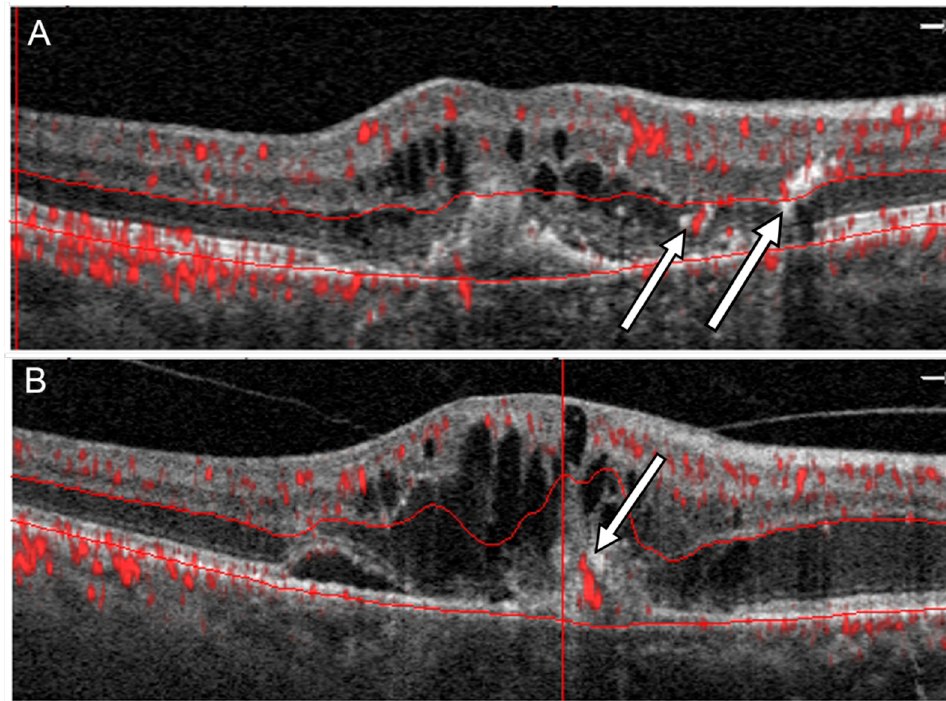
Figure 1. Two different patterns of flow in RAP in OCTA: ( A ) A flow signal in outer retina in vicinity of hyperreflective lesions corresponding to IRN (arrows), ( B ) a flow signal passing through the RPE corresponding to CRA (arrow).